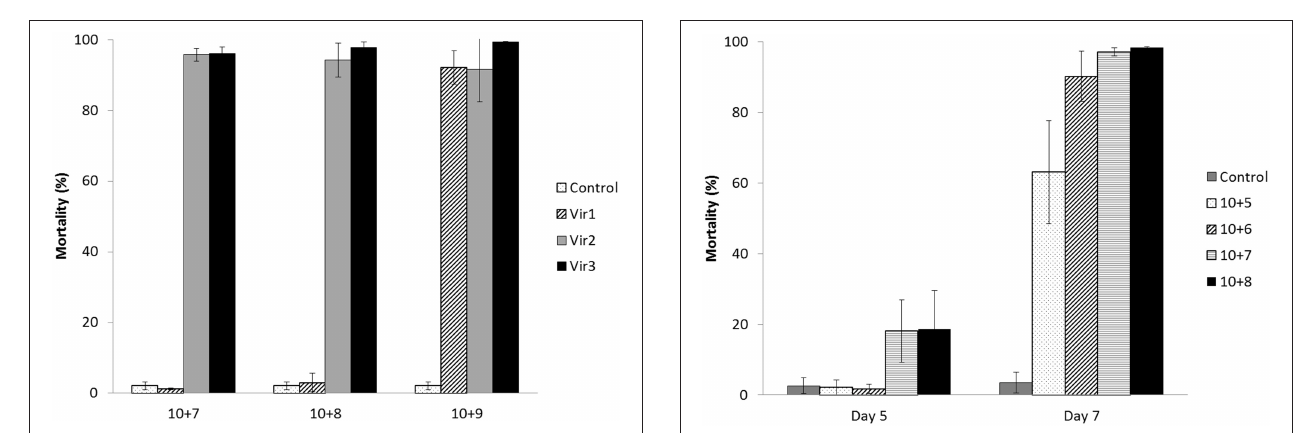
FIGURE 1 | Mortality (% ± SD) of 4 days old unselected oyster larvae at day 5 post-exposure in trial 1a. Three viral suspensions (Vir1, Vir2, and Vir3) and three concentrations were used (10 + 7 , 10 + 8 , and 10 + 9 DNA copies L − 1